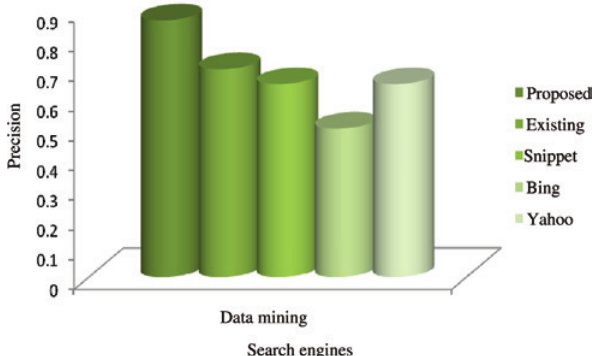
Figure 2: Precision Comparison for the User-Given Query “Data Mining” When Topmost Links Are Taken.